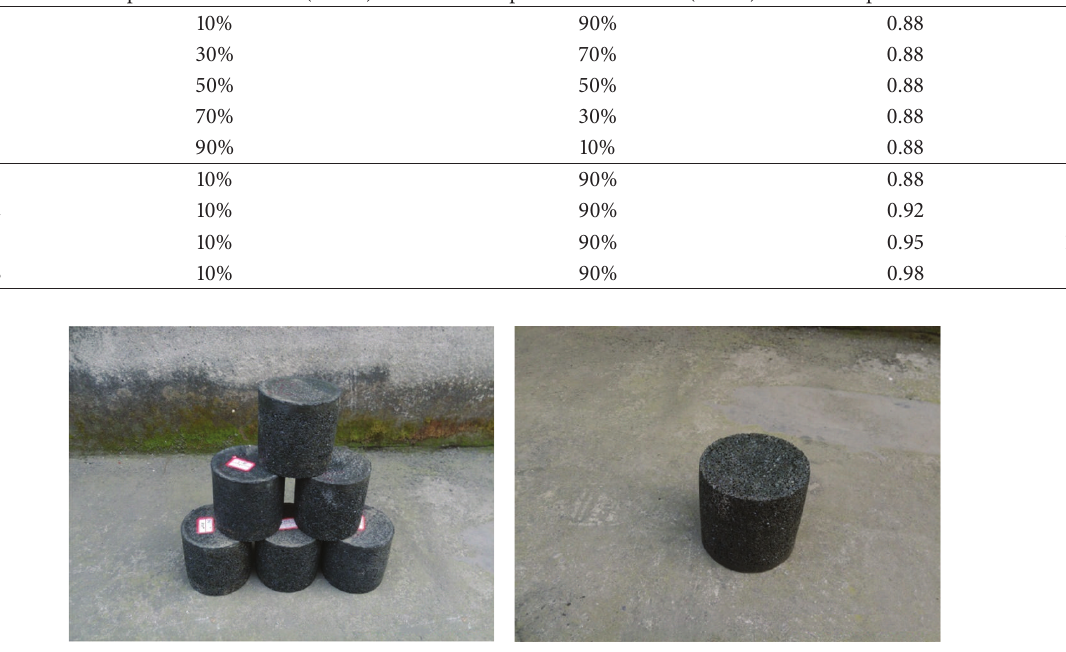
Figure 3: Specimens obtained from the end-of-life